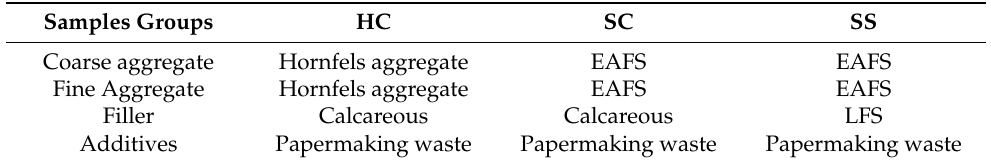
ladle furnace slag, calcareous filler, and fibers from the papermaking industry.